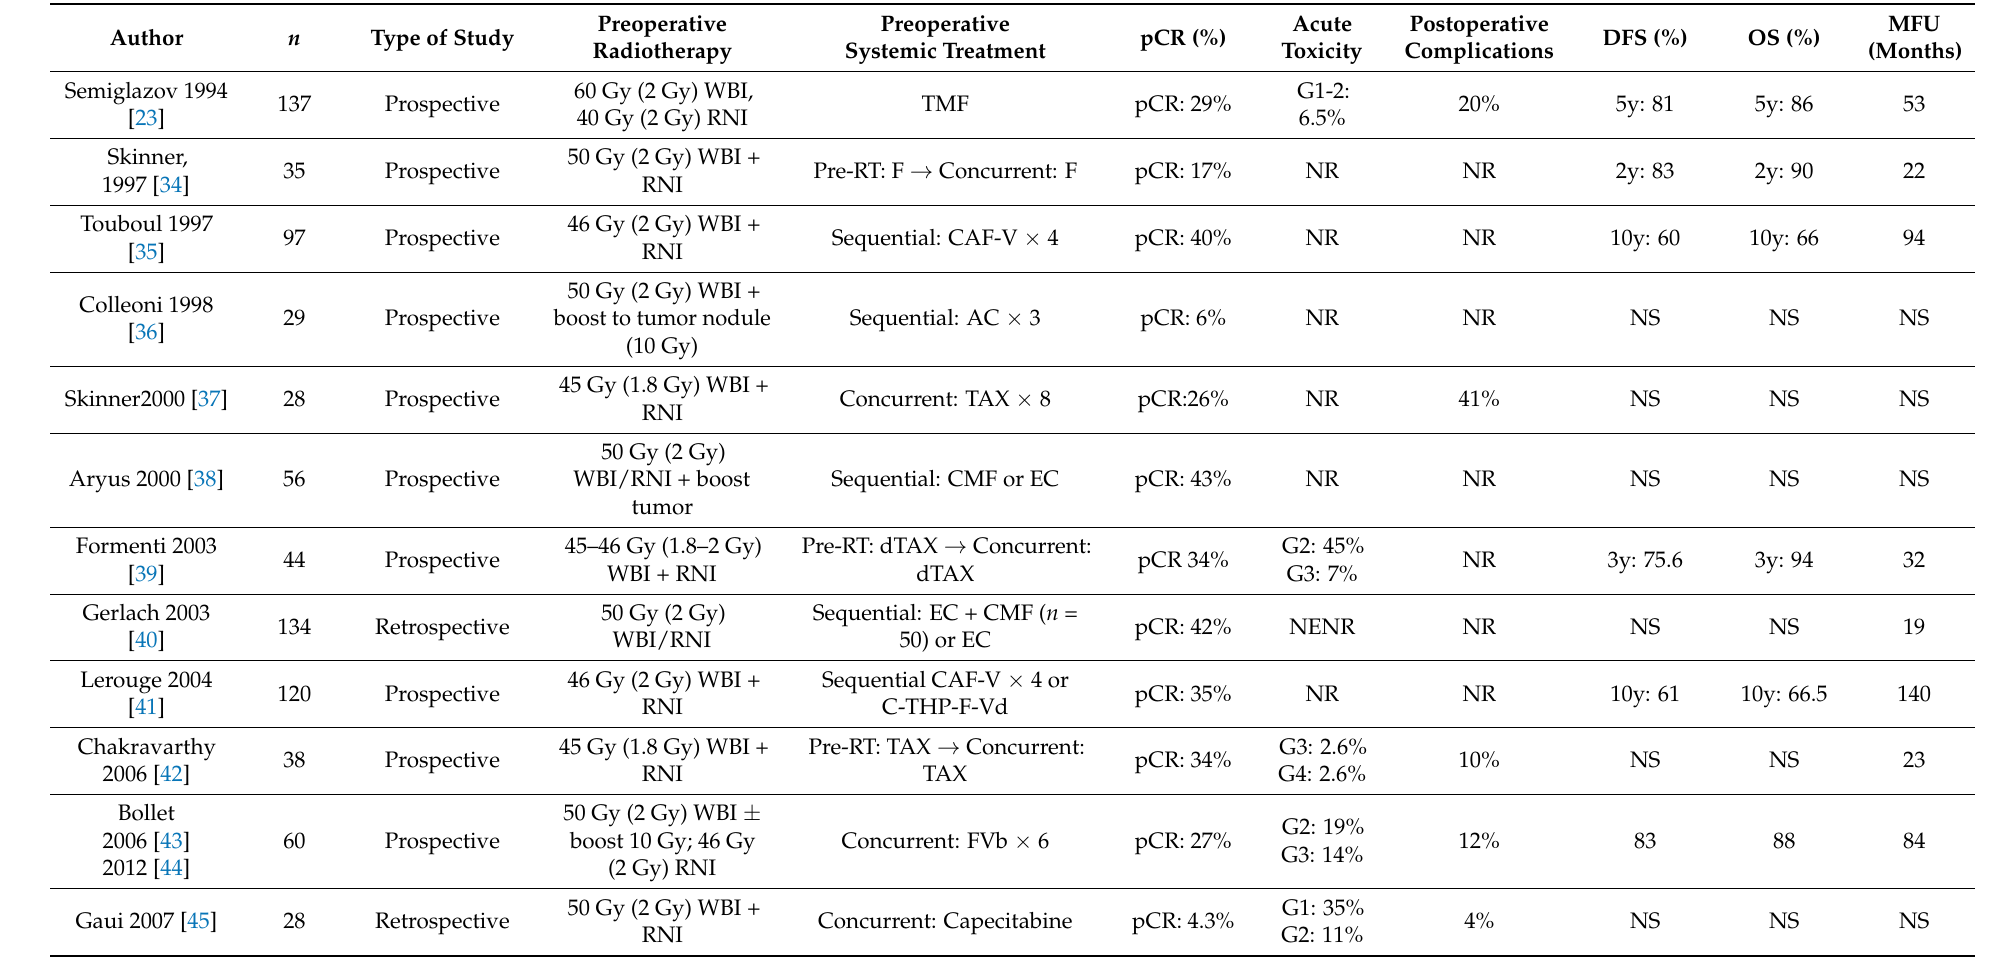
Table 2. Studies of preoperative chemo-radiotherapy published to